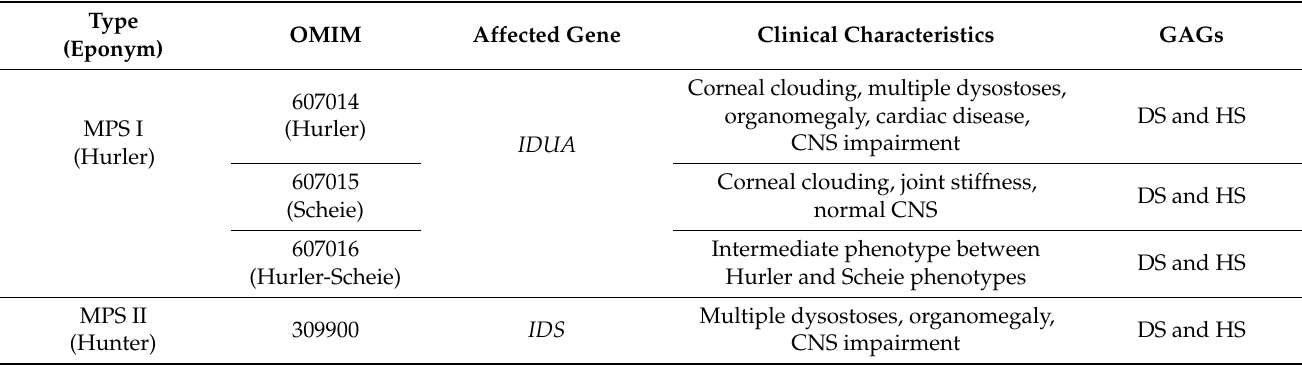
Table 2. Classification of MPS and major